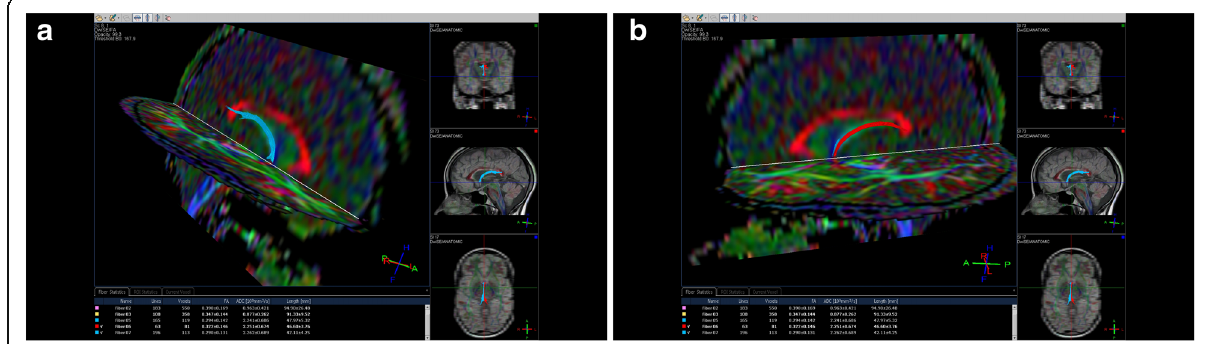
Fig. 3 30-year-old female patient known to have MS with depressive symptoms (BDI 25). Colour-coded FA maps overlaid on FLAIR images with 3D fibre tractography of the fornix. a Right side and b left side showing FA reduction of the right and left fornix (FA 0.290 ± 0.131 on the right and 0.322 ± 0.146 on the left)